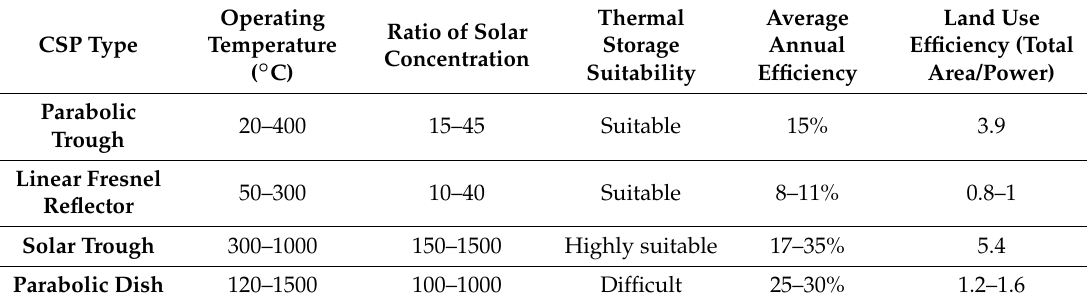
Table 1. Comparison of CSP technologies